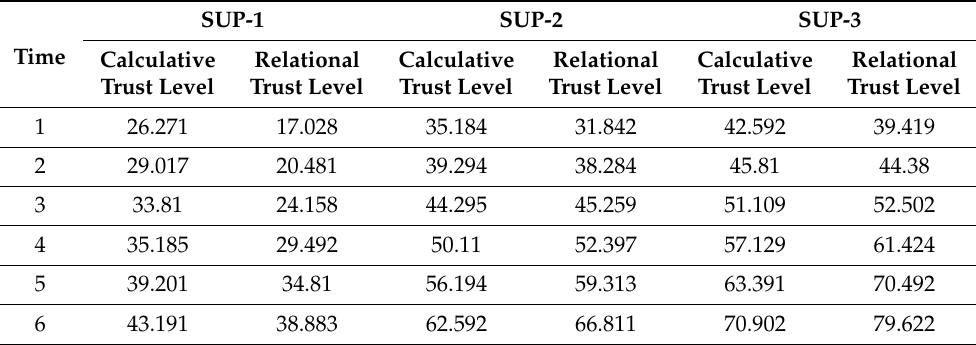
Table 3. Scenario B simulation results.